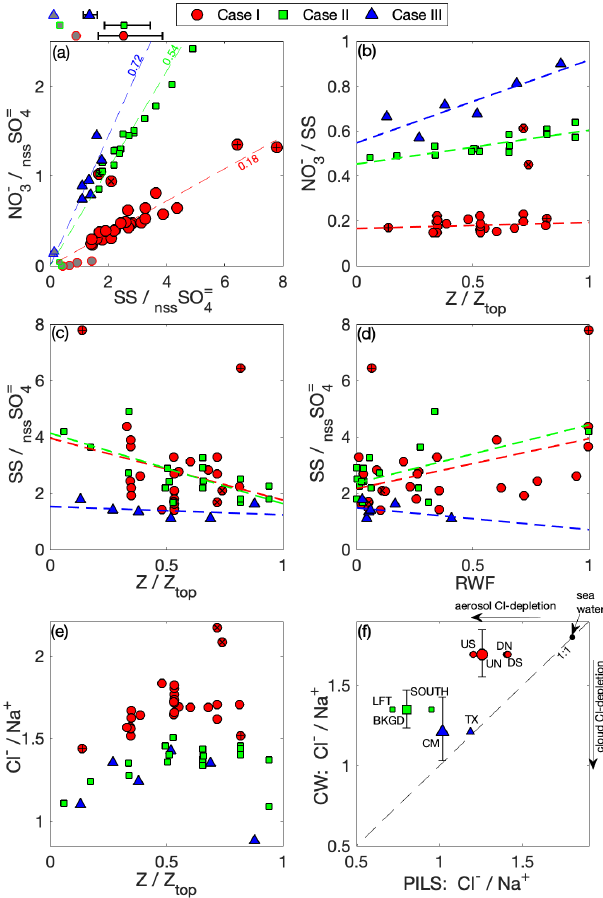
− and nss SO 2 − . (a) The Figure 9. Relationships among SS, NO 3 4 CW mass ratios of SS to nss SO 2 − are compared to mass ratios of 4 NO − to nss SO 2 − for each case, with relevant sub-cloud air-mass 3 4 PILS data included for contrast (grey fill). Above the panel, the (ge- ometric) mean SS: nss SO 2 − mass ratio is shown (with 1 σ variabil- 4 ity) for CW for each case. Dashed lines (with slope indicated) show case mean NO − :SS mass; (b) CW NO − :SS mass against normal- 3 3 ized altitude; CW SS: nss SO 2 − mass against (c) normalized altitude 4 and (d) RWF; (e) CW Cl − :Na + mass against normalized altitude; (f) sub-cloud aerosol (PILS) Cl − :Na + mass ratio compared against the equivalent CW Cl − :Na + mass ratio. Case I with outlying ratios is highlighted: high-NO − pair ( × ), high-SS pair 3